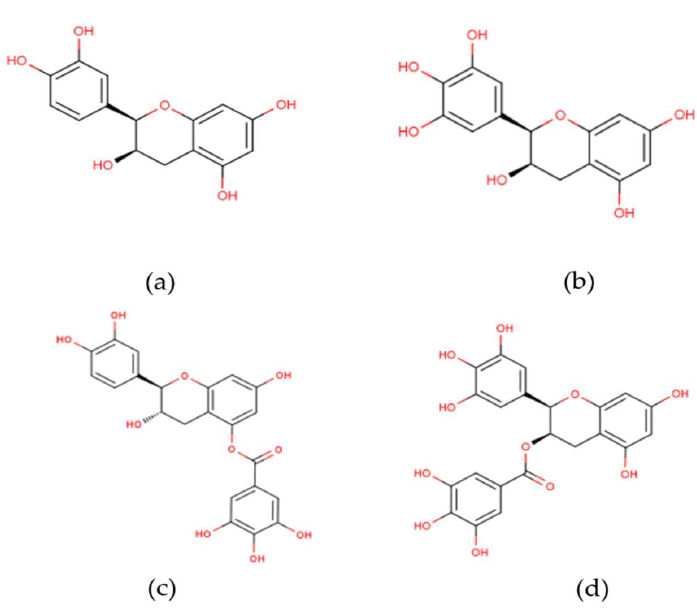
Figure 1. Chemical structures of the four main green tea catechins ( a ) Epicatechin; ( b ) Epigallocatechin; ( c ) Epicatechin-3-gallate; ( d ) Epigallocatechin-3-gallate. Adapted from [6,18] .